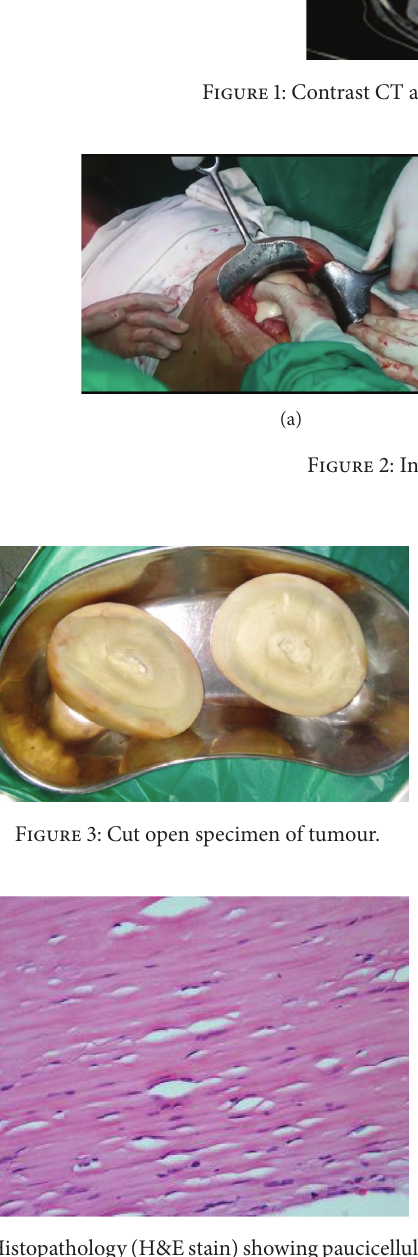
Figure 4: Histopathology (H&E stain) showing paucicellular, unen- capsulated hyalinised tissue with calcification.